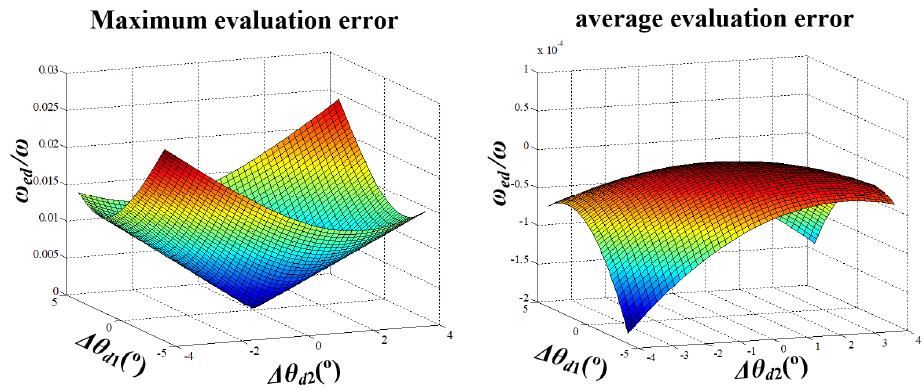
Figure 6. The evaluation error of the rotational speed with angular changing distribution error.